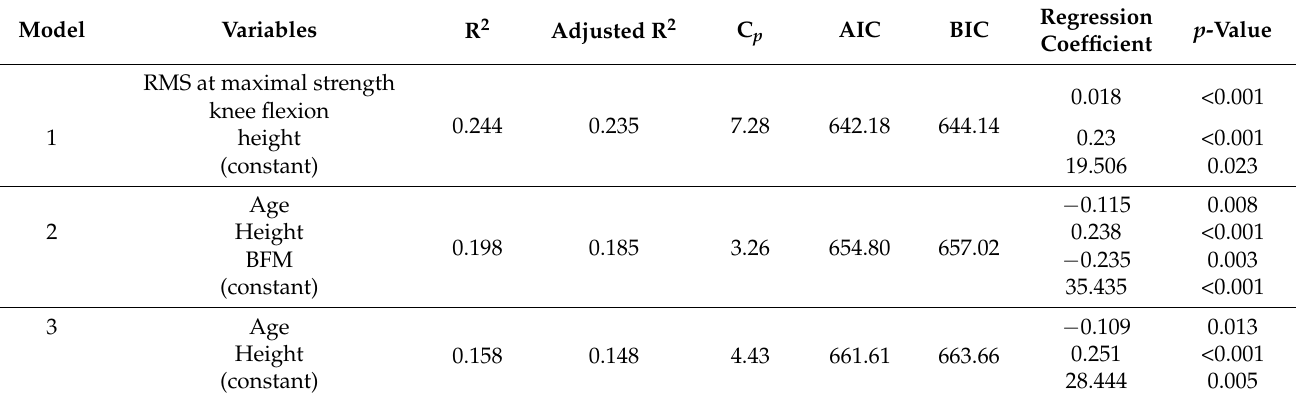
Table 4. The three-step length estimation models using age, height, BFM, and RMS value at maximal strength knee